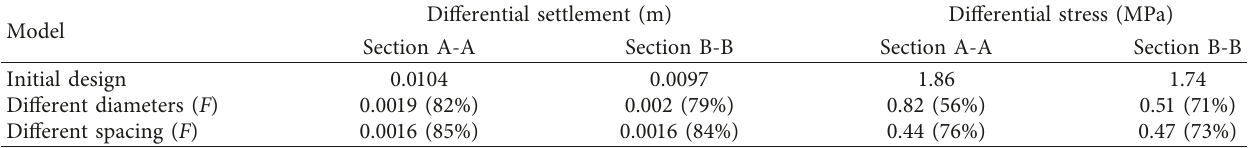
Table 10: Details of the comparison between the initial design and optimal design.